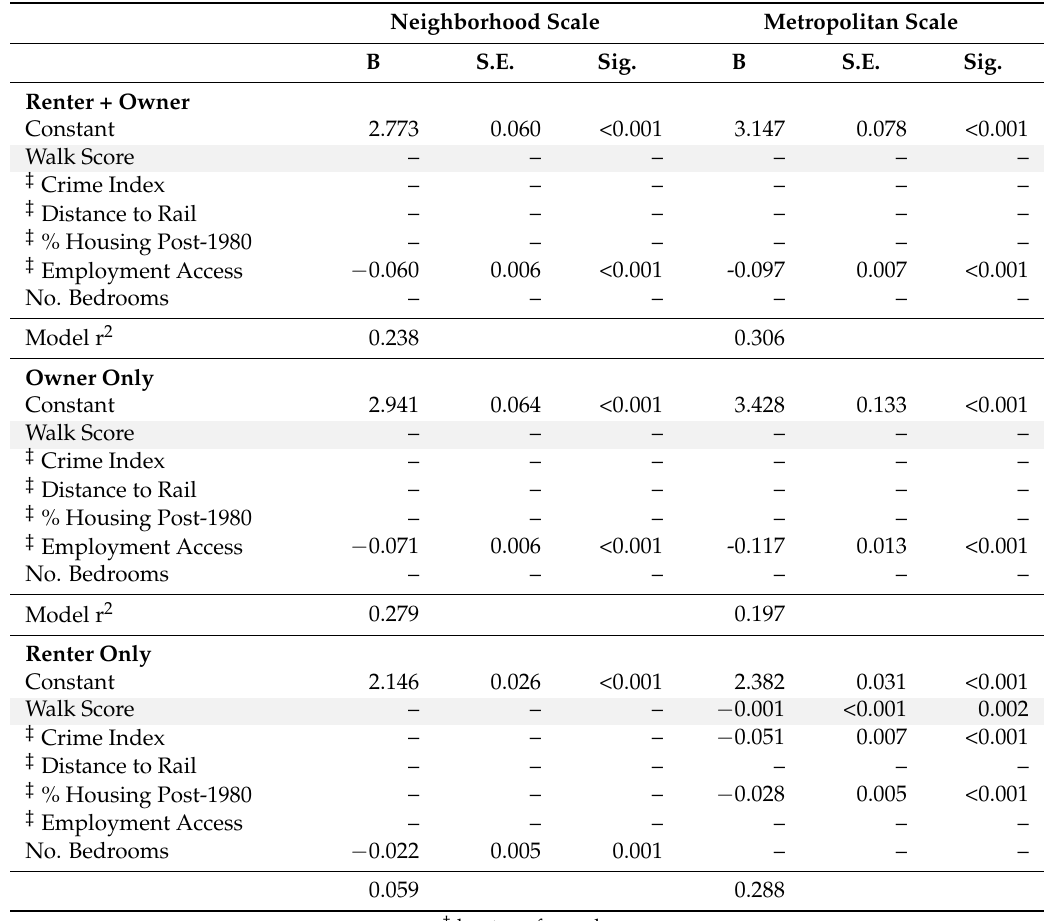
Table 4. Results of the OLS regression analyses (stepwise procedure) for the Portland, OR urbanized area, with the log(10) of the combined renter and owner (CHAI), owner only (HAI), and renter only (RAI) housing affordability indices as the dependent